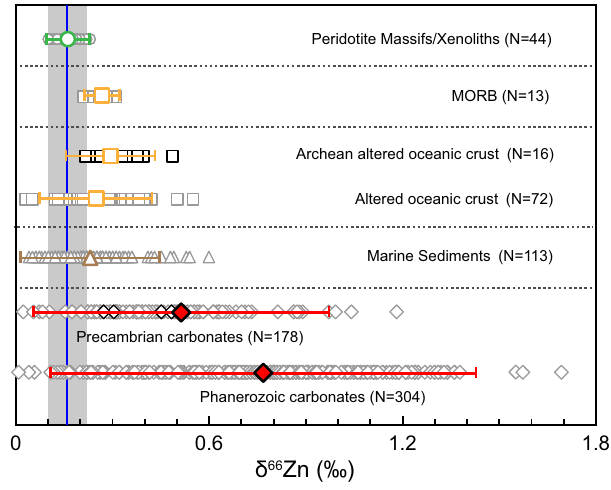
Fig. 1 | Zinc isotopic compositions of mantle peridotite and several crustal reservoirs. The blue line marks the average δ 66 Zn value of the peridotitic mantle ( δ 66 Zn=0.16 ‰ , ref. 27) and the vertical gray fi eld marks the δ 66 Zn range of the peridotitic mantle ( δ 66 Zn=0.10 ‰ ~0.22 ‰ , ref. 27). The number of samples (N), average δ 66 Znvaluesand2standarddeviations(2SD)aregiven.Referencedataare shownassymbolswithgray rims,and dataofthisstudyare shownassymbolswith black rims. See Supplementary Information, Note 6 for data sources. MORB=Mid- Ocean Ridge Basalt.